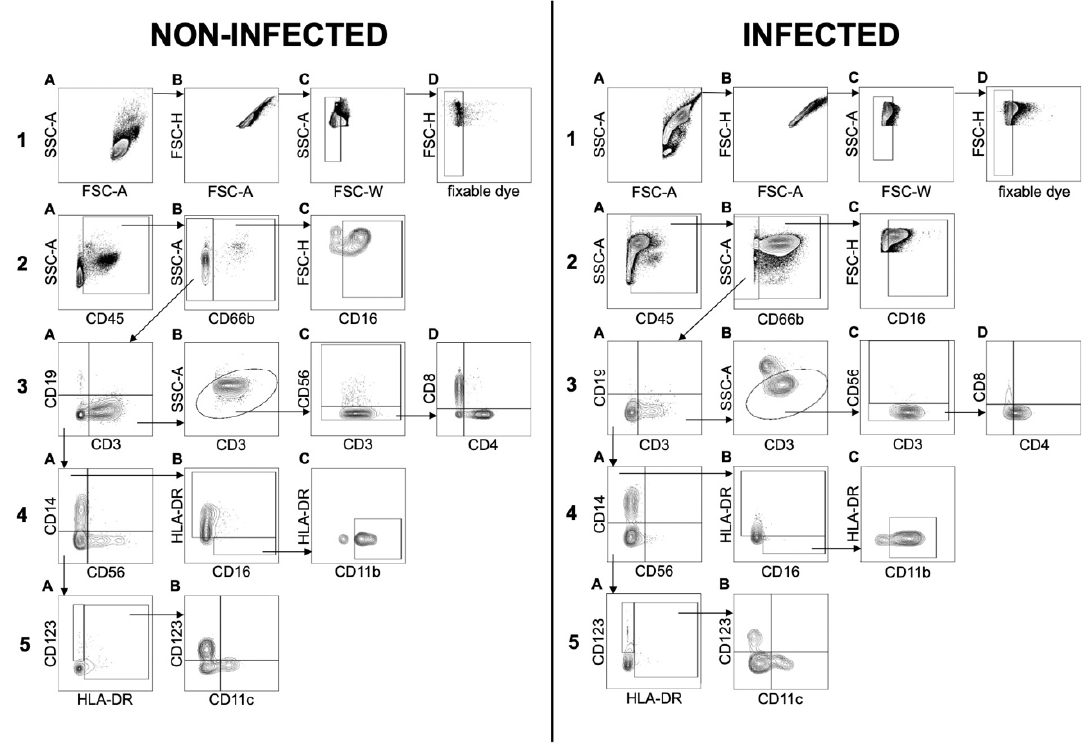
Figure 3. Flow cytometry analysis of leucocyte populations present in the synovial fluid of non-infected ( left ) and infected ( right ) patients. The gating strategy for all samples was performed as following: General cell distribution of the whole sample is shown in ( 1A ). First, exclusion of doublets ( 1B , C ) using FSC-A / FSC-H and FSC-W / SSC-A and dead cells ( 1D ) using fixable dye. Further gating for CD45 enabled selection of only leucocytes for further investigation ( 2A ). The leucocytic population was divided into CD66b + neutrophil and eosinophil granulocytes and CD66b − cells ( 2B ). Neutrophil and eosinophil granulocytes were identified based on the expression of CD16 ( 2C ). All CD66b − cells were gated for the expression of CD3 and CD19 to distinguish potential T cells from B cells ( 3A ). SSC in combination with CD3 expression was used to minimize contamination of the previously gated CD3 + population ( 3B ). Expression of CD56 was used to detect NKT cells ( 3C ). All other CD3 + cells were gated for CD4 and CD8 to isolate T h and T k cells ( 3D ). Boolean gating of non-gated cells in 3B and all CD3 − and CD19 − cells was performed. The resulting population was analyzed for CD56 and CD14 expression to identify NK cells and monocytic cells, respectively ( 4A ). The monocytic population was divided into HLA-DR + monocytes and HLA-DR − and CD16 + potential mMDSCs (monocytic myeloid-derived suppressor cells) ( 4B ). Potential mMDSCs were identified using CD11b ( 4C ). The remaining cells were gated for HLA-DR and CD123 expression to distinguish basophile granulocytes from potential dendritic cells ( 5A ). Myeloid (mDCs) and plasmacytoid dendritic cells (pDCs) were identified by expression of CD11c ( 5B ).